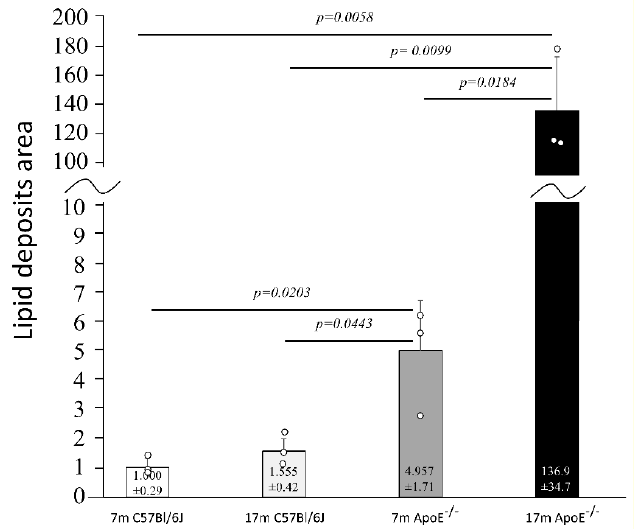
Figure 2. Senescence-related increase of the area of lipid deposits in liver cells. The relative area of lipid droplets in liver tissue of C57Bl/6J and ApoE − / − mice is shown in relation to corresponding controls (7 months old). The actual area of lipid deposits in ApoE − / − mice was larger than in C57Bl/6J mice; shown is the average number of pixels (pxs) attributed to lipid deposits normalized to a mean of 7m C57Bl/6J for visualization purposes. Data were analyzed by a two-way ANOVA test (the exact F values for genotype and age are 48.16 and 43.57, respectively), followed by Dunn–Sidak’s multiple comparison post-hoc test. Shown are the means ± standard deviations. The significance of differences between compared groups are marked with obtained p -values ( p ) for each significant comparison; the different genotype groups were not littermates; row data are depicted by circles; m–months.